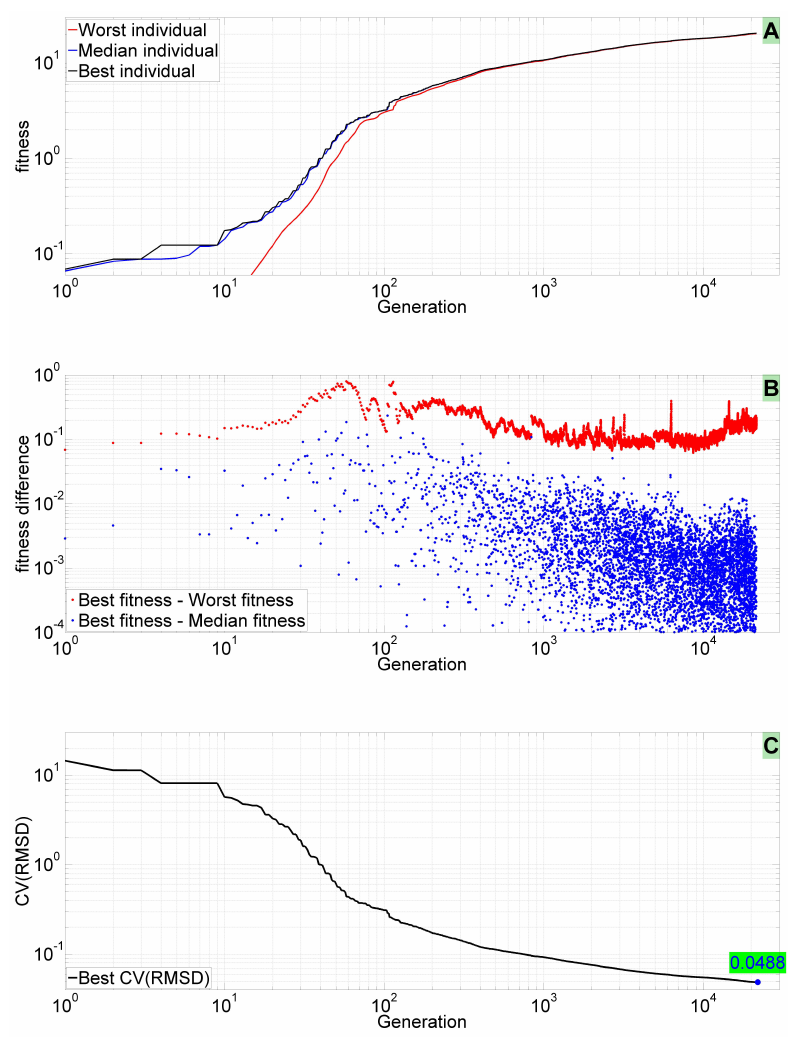
Fig. 4. (A) Evolution of the worst, median, and the best individuals from the 1st generation to the final 21,549th generation; (B) The fitness differences between the best and the worst individuals, and between the best and median individuals; (C) Evolution of the best CV(RMSD) from 14.514 at the 1st generation to 0.0488 in the final 21,549th